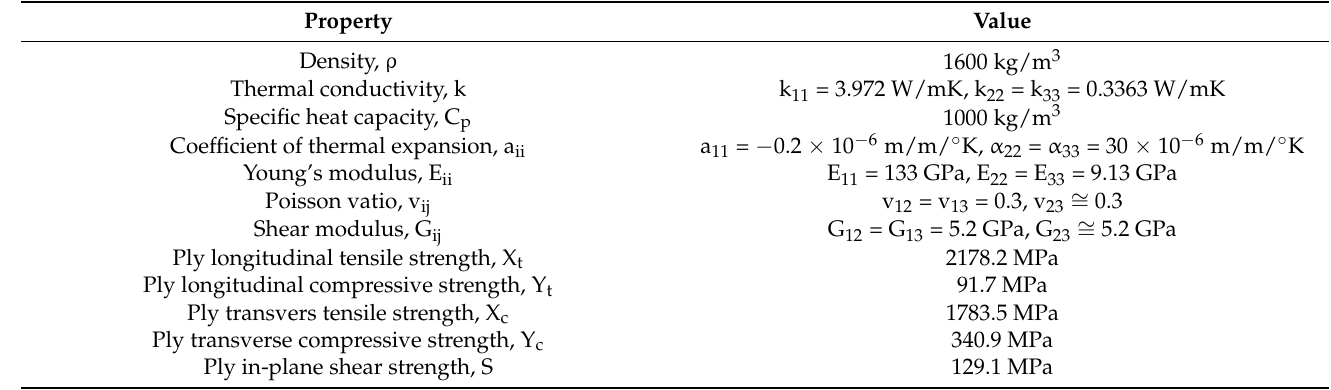
Table 2. Properties of the composite material of the outer tank shell.